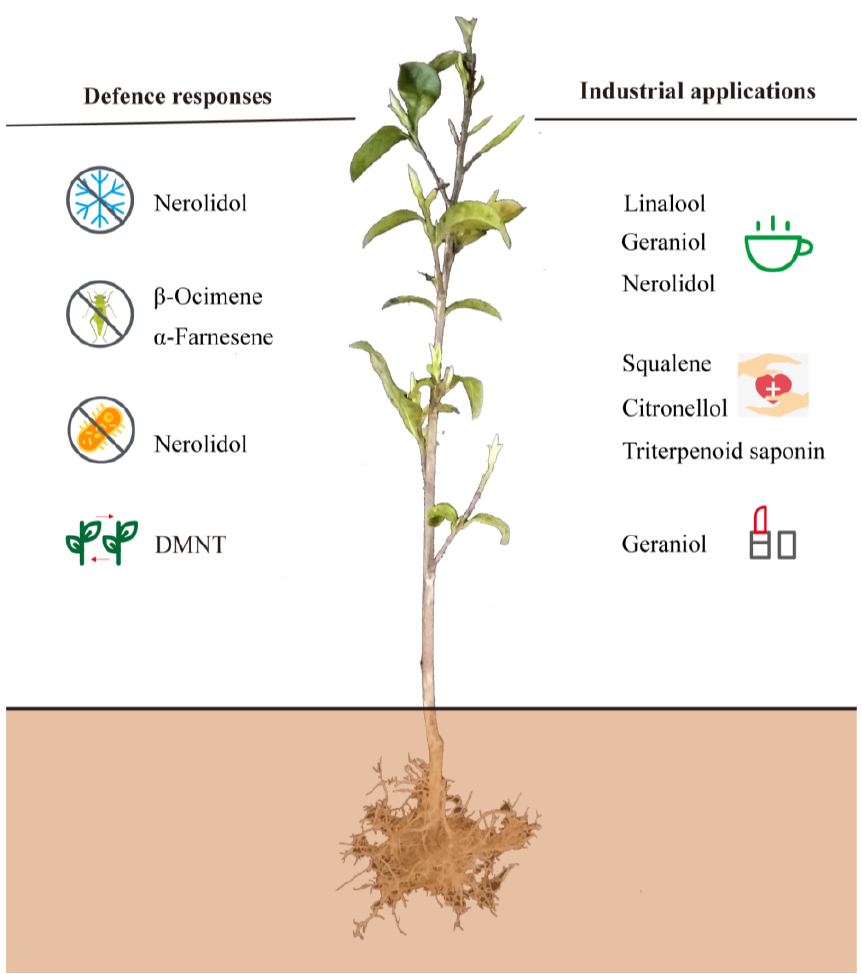
Figure 1. Important functions of main terpenoids in tea plants. DMNT, (3 E )-4,8-Dimethyl-1,3,7- nonatriene.